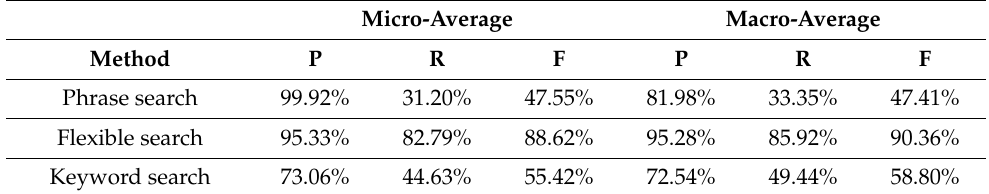
Table 5. Evaluation